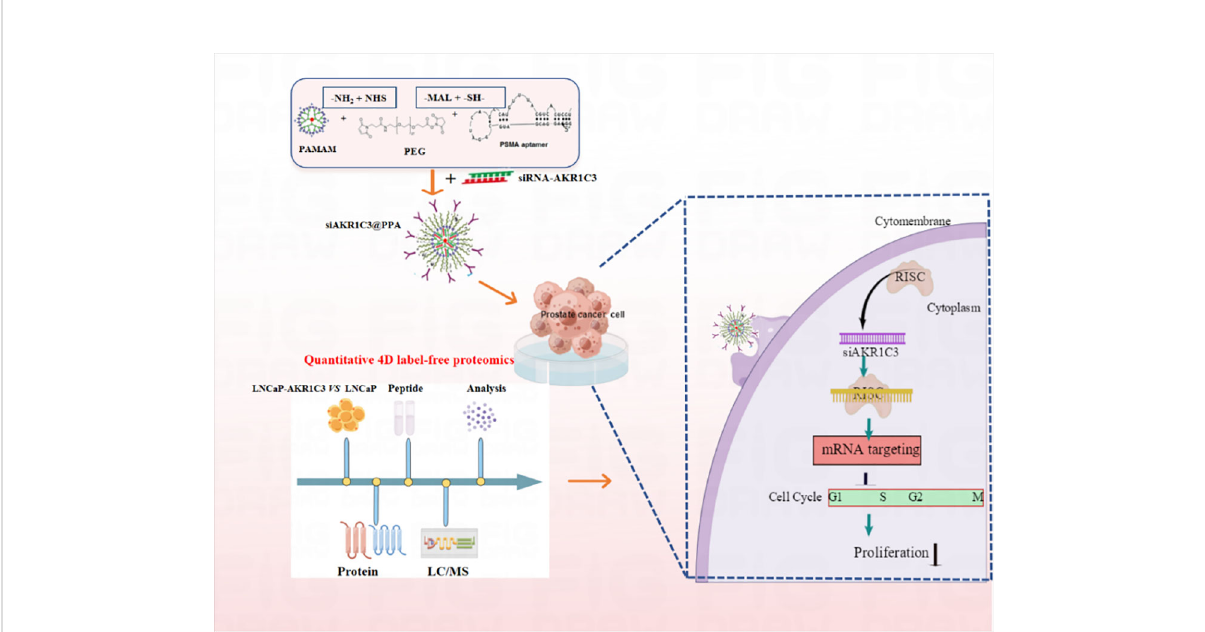
FIGURE 8 Nucleic acid nanoparticles siAKR1C3@PPA complex targeted inhibits proliferation of CRPC cells. The NH 2 group of PAMAM was covalently bound to the -NHS group of PEG. The sulfhydryl group of Apt-PSMA can continue to react with MAL of PEG.PAMAM and Aptamer were respectively attached to dual-function PEG via stable covalent bonds, resulting in the PPA that was still positively charged and can self-assemble with siRNA.Aptamer-PSMA acts as a target to guide siAKR1C3@PPA into PSMA-positive prostate cancer cells and speci fi cally down regulate AKR1C3. Regulating Cell Cycle-related protein expression and inhibiting cell proliferation by decreasing AKR1C3 protein expression. Black arrow indicates negative